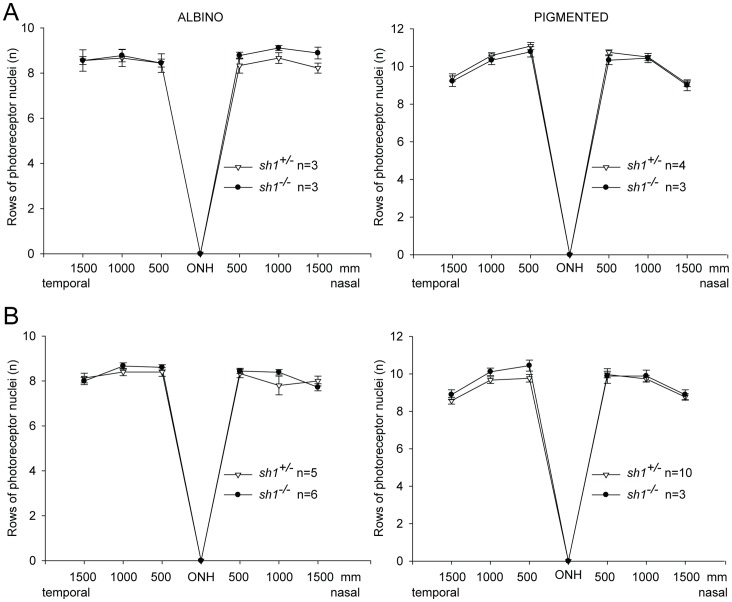
Number of rows of photoreceptor nuclei in the outer nuclear layer of albino (left panels) and pigmented (right panels) sh1 mice.Data are from mice at 6 (A, left panel), 6–7 (A, right panel) or 12 (B) months of age. Data are presented as mean±SEM; n indicates the number of eyes analyzed; ONH: optic nerve head. No statistically significant differences were found between sh1+/− and sh1−/− mice. More details on the statistical can be found in the Statistical analysis paragraph of the Materials and Methods section.